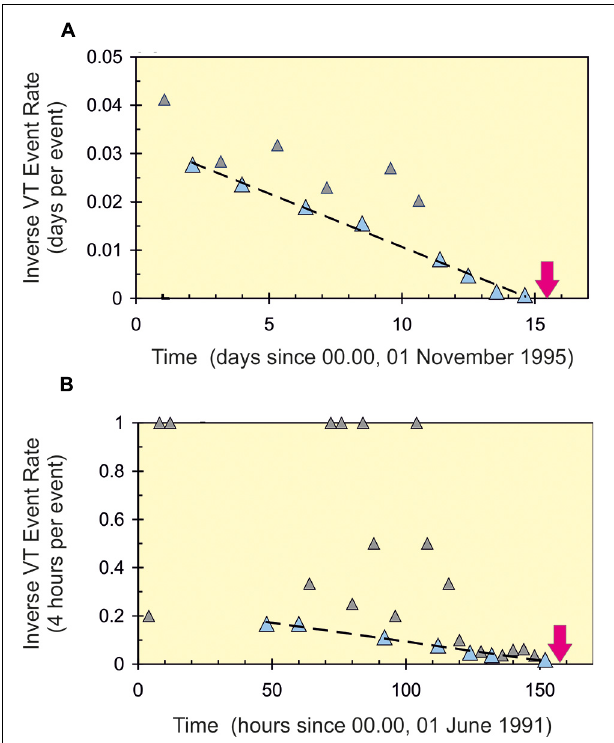
FIGURE 7 | Linear decreases ( dashed lines ) in inverse-rate minima for VT events ( large triangles ) before magmatic eruptions ( arrows ) after centuries of repose at (A) Soufriere Hills, Montserrat (gradient –2.4 × 10 - 3 per event), and (B) Pinatubo, Philippines (gradient –6.4 × 10 - 3 per event). The trends are equivalent to the hyperbolic increases in VT rate expected for inelastic behavior; the inverse-rate minima thus correspond to local peaks in VT rate. Data from Kilburn (2003).